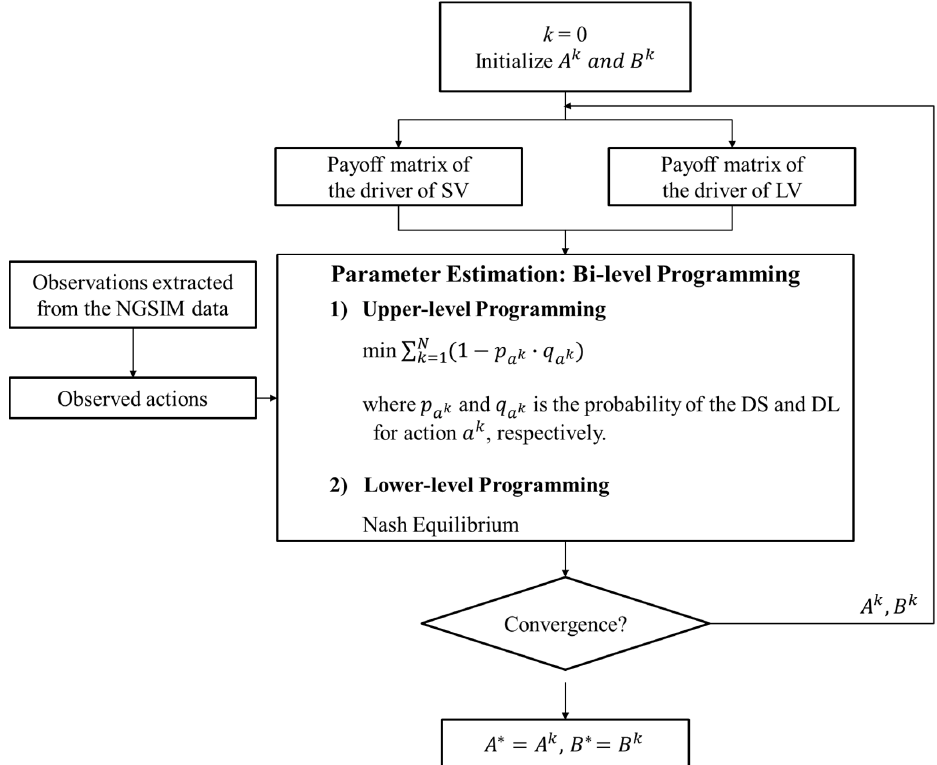
Figure 7. Schematic workflow for bi-level programming.